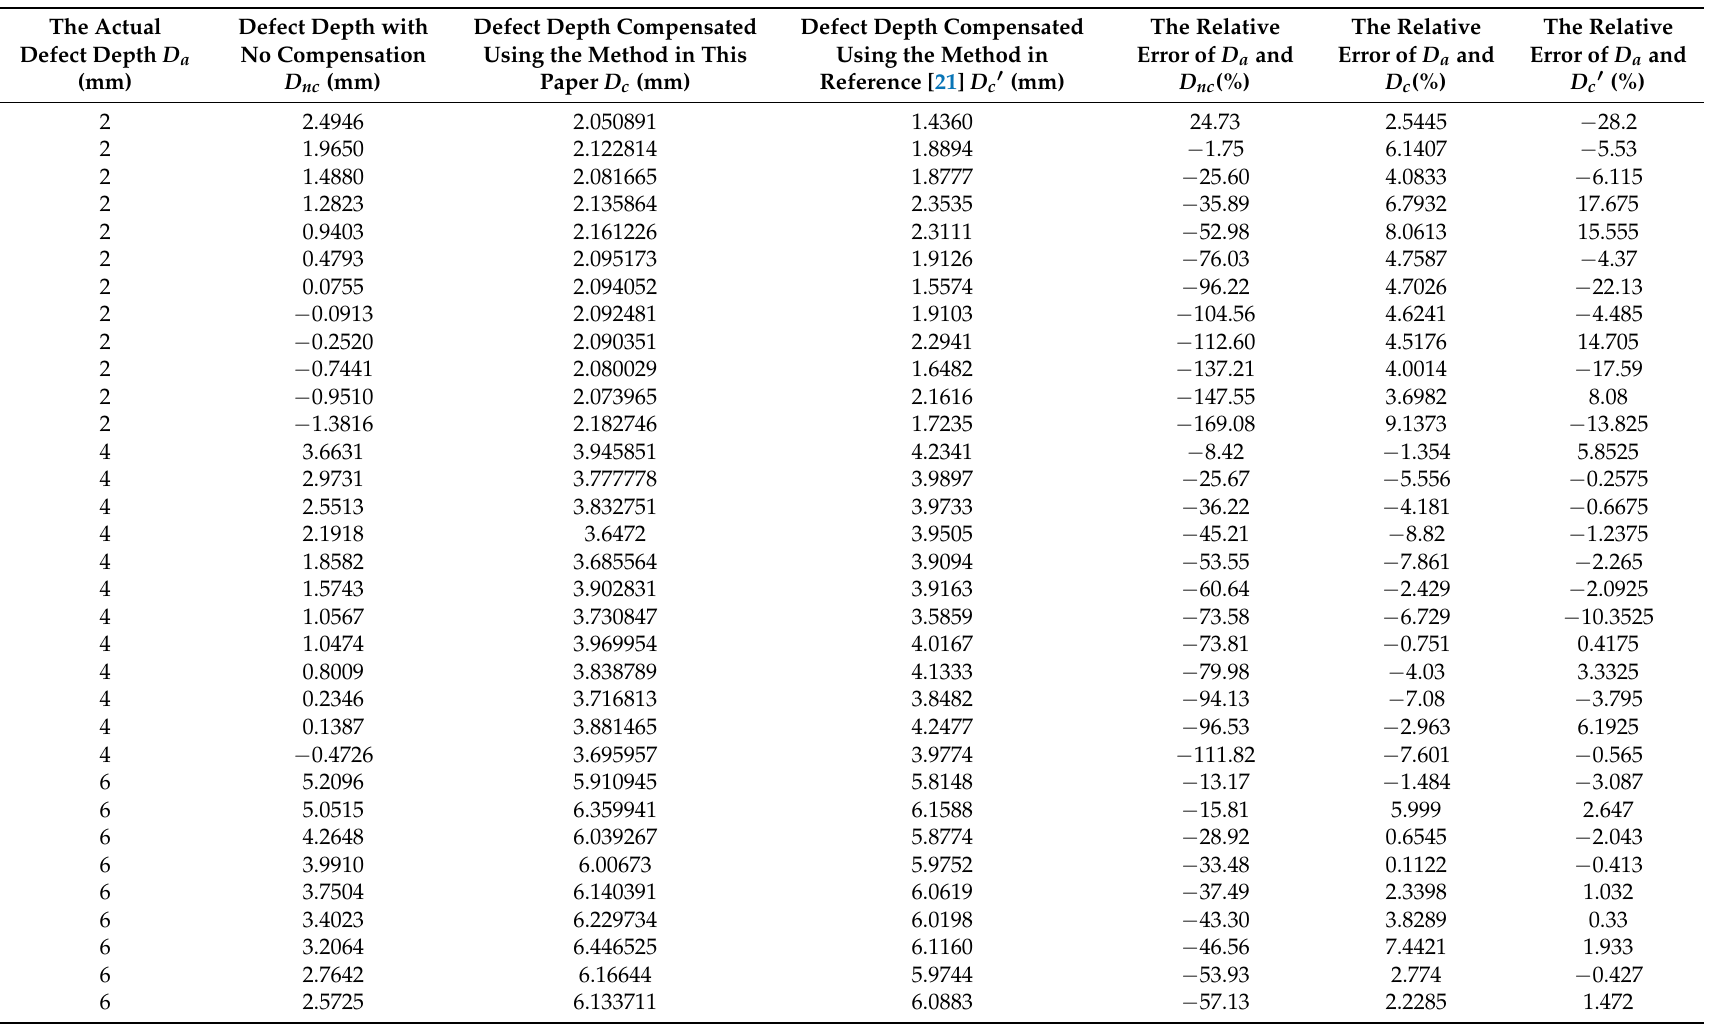
Table 2. Comparison of the relative